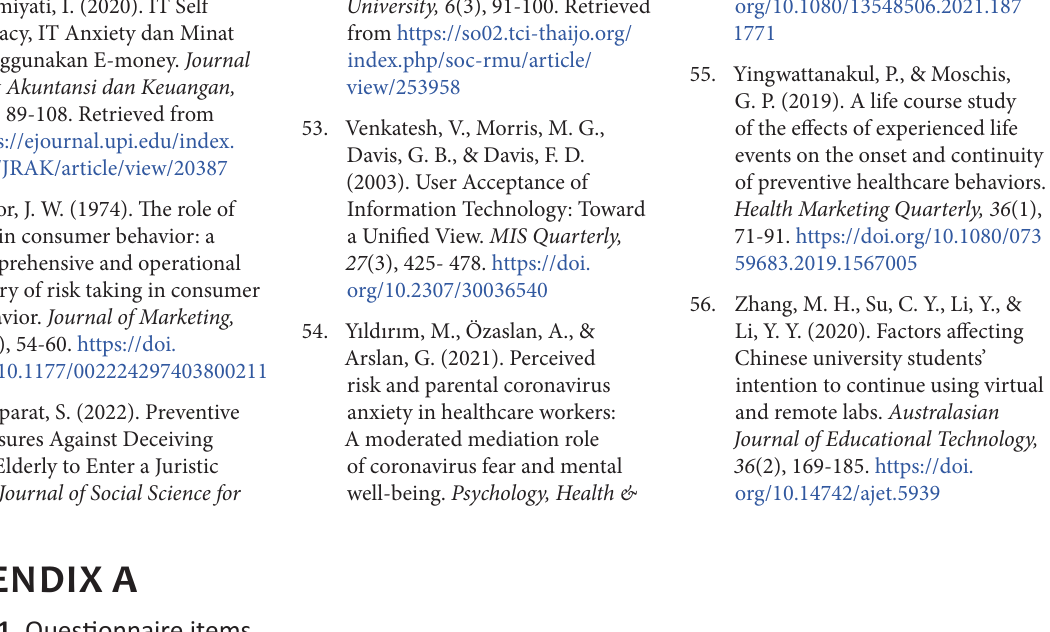
Table A1. Questionnaire items Variable